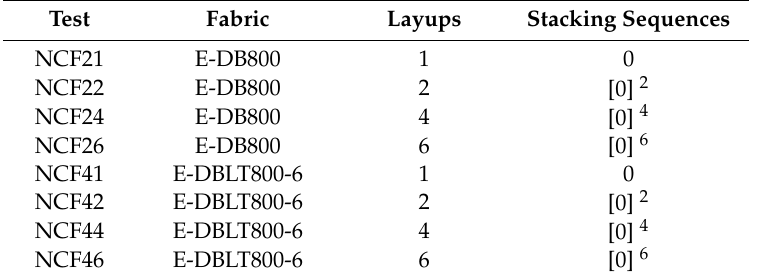
Table 4. Layer numbers and stacking sequences of the preforms used in